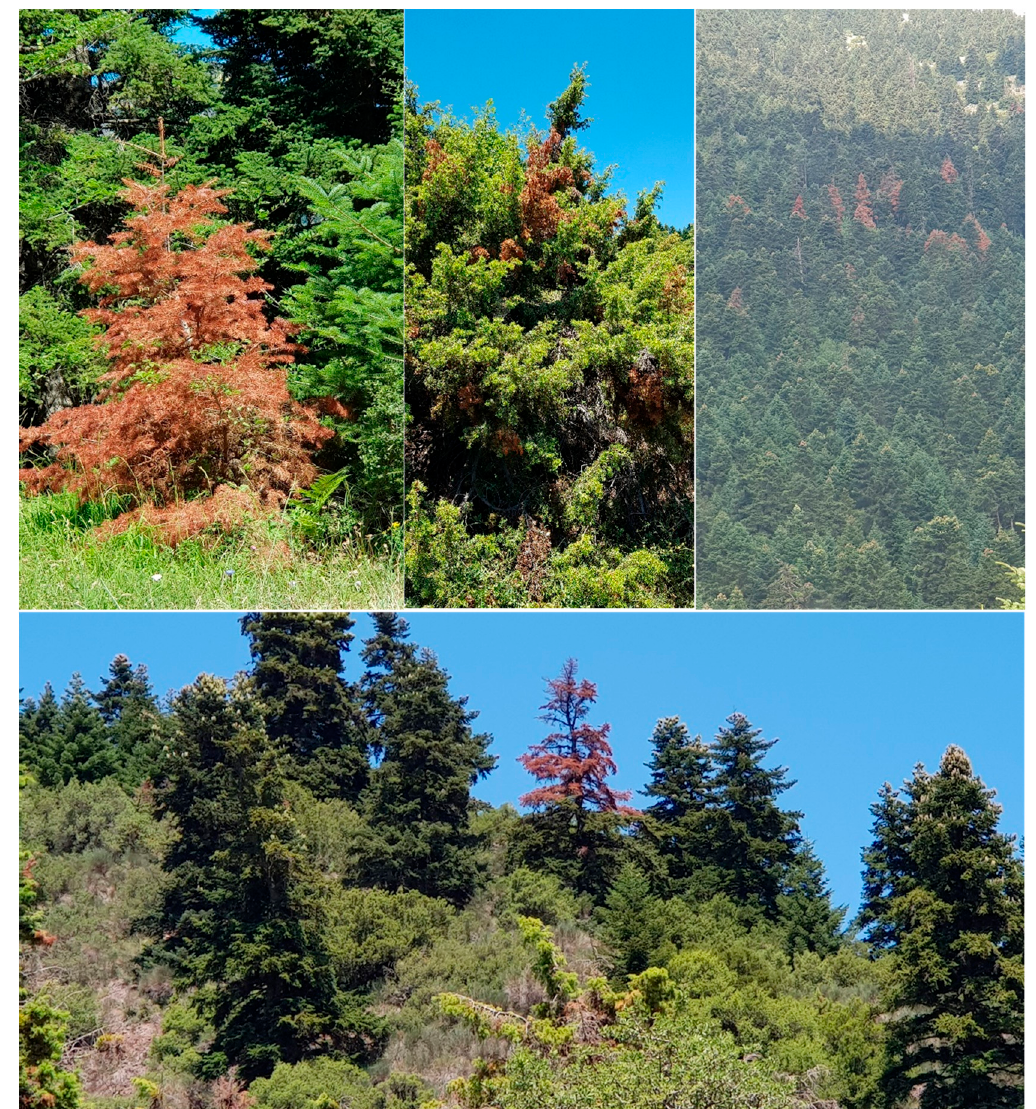
Figure 5. Giona Mt photos EFB infestations in altitudes lower than 1100 m, in mature trees but in nature regeneration as well.